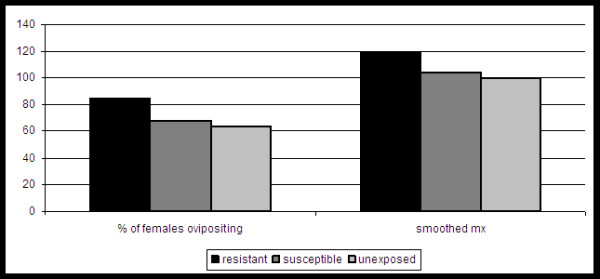
Combined fecundity of individual groups of Cx. pipiens. The percent of females ovipositing refers to individuals producing at least one egg raft during the study and smoothed mx refers to the average daily reproductive output while surviving. No significant differences were measured in these statistics (fisher's exact, p > 0.05).